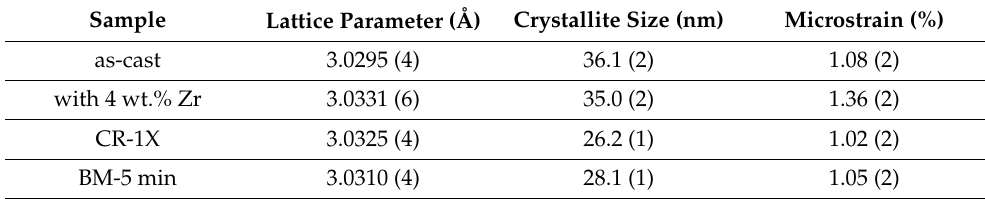
Figure 3. X-ray diffraction patterns of Ti 16 V 60 Cr 24 (with and without Zr addition) in various initial states. Table 2. Crystal parameters of Ti 16 V 60 Cr 24 at various initial states. Numbers in parentheses are the error son the last significant